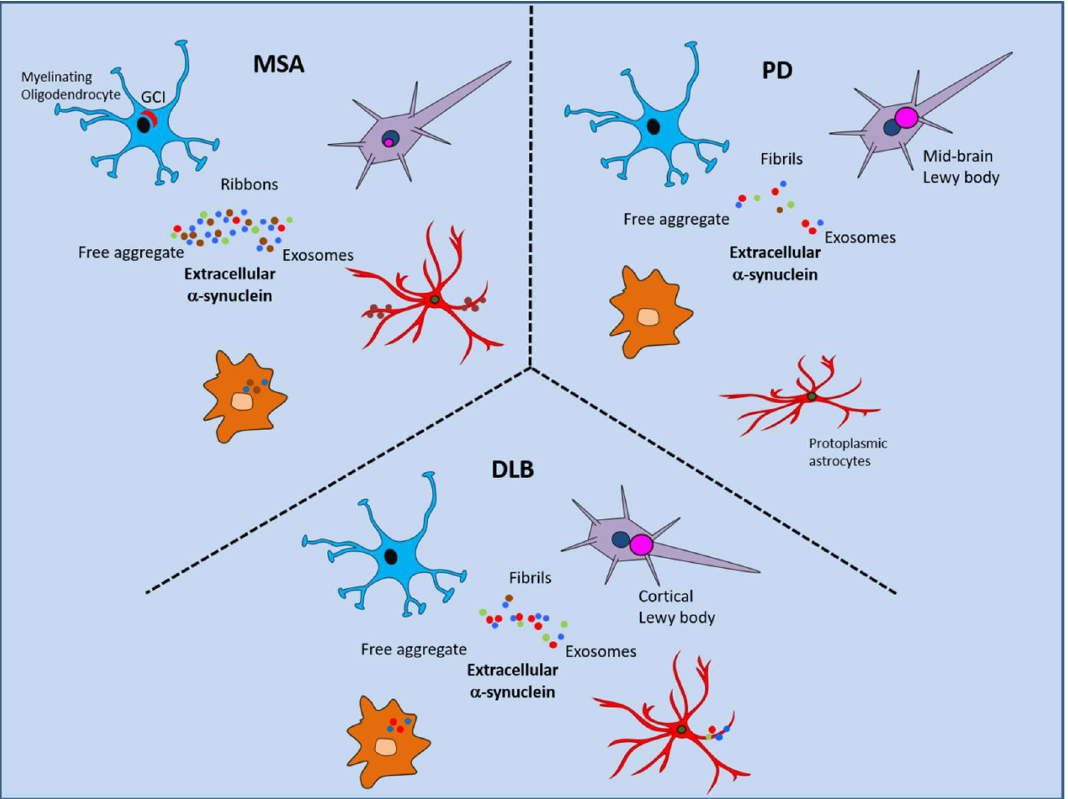
Figure 2. Differential interactions of extracellular α-syn in MSA, PD and DLB. Hypothetical scheme highlighting the differences in pathology that may arise due to variations in abundance, spread and strains of extracellular α-syn. All three diseases have reduced α-syn in CSF samples compared to controls and AD, indicating normal α-syn clearance is decreased or dysfunctional which might be due to altered glymphatic system and astrocytes. Microglial activation and clearance of α-syn by microglia is reduced in PD compared to MSA. Increased oligodendrocyte and astrocyte accumulation of α-syn by uptake in MSA suggests increased brain extracellular α-syn. Neurons show some α-syn pathology in MSA but this tends to be intranuclear and in areas related to neurodegeneration but also varies in cellular localization throughout the brain. Myelinating oligodendrocytes form GCIs whereas oligodendrocyte precursor cells do not. Whereas, non-myelinating oligodendrocytes develop α-syn pathology in PD but not until late stages. Oligodendrocytes may transmit α-syn between themselves along myelinating tracts. Protoplasmic astrocytes develop non-phosphorylated α-syn pathology in PD and are associated with a non-reactive, degenerative phenotype. Astrocytes are highly activated in MSA but α-syn accumulation is more correlated with age-related astrocyte gliopathy. α-Syn ribbons are taken up by oligodendrocytes and fibrils by neurons.